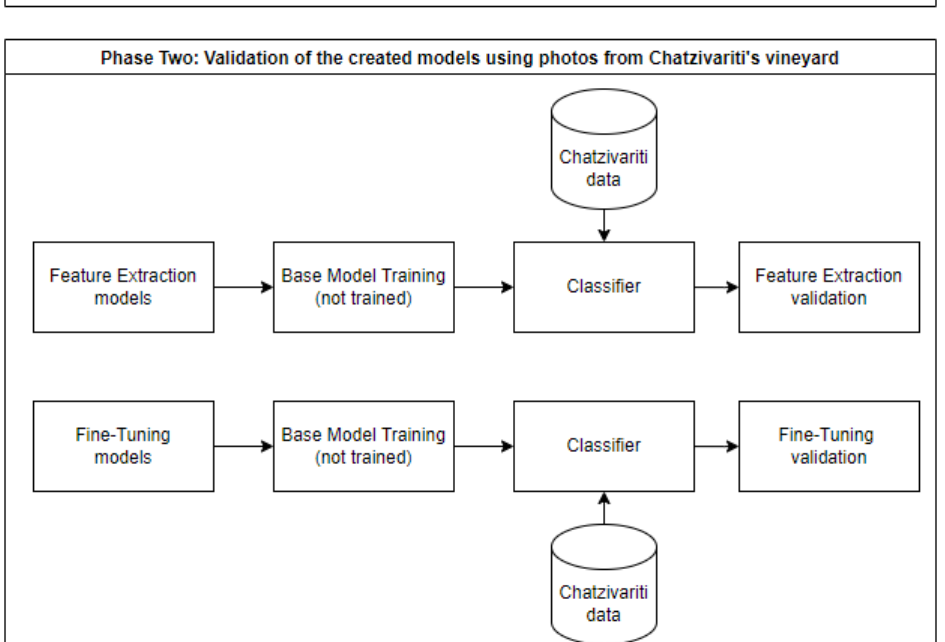
Figure 7. Description of the two phases of the DCNN training. The first phase shows the initial training using the PlantVillage dataset for the creation of classifiers with the feature extraction and fine-tuning training approaches. The second phase shows the validation of the first phase using the data from Chatzivariti’s vineyard for the training of the classifiers.